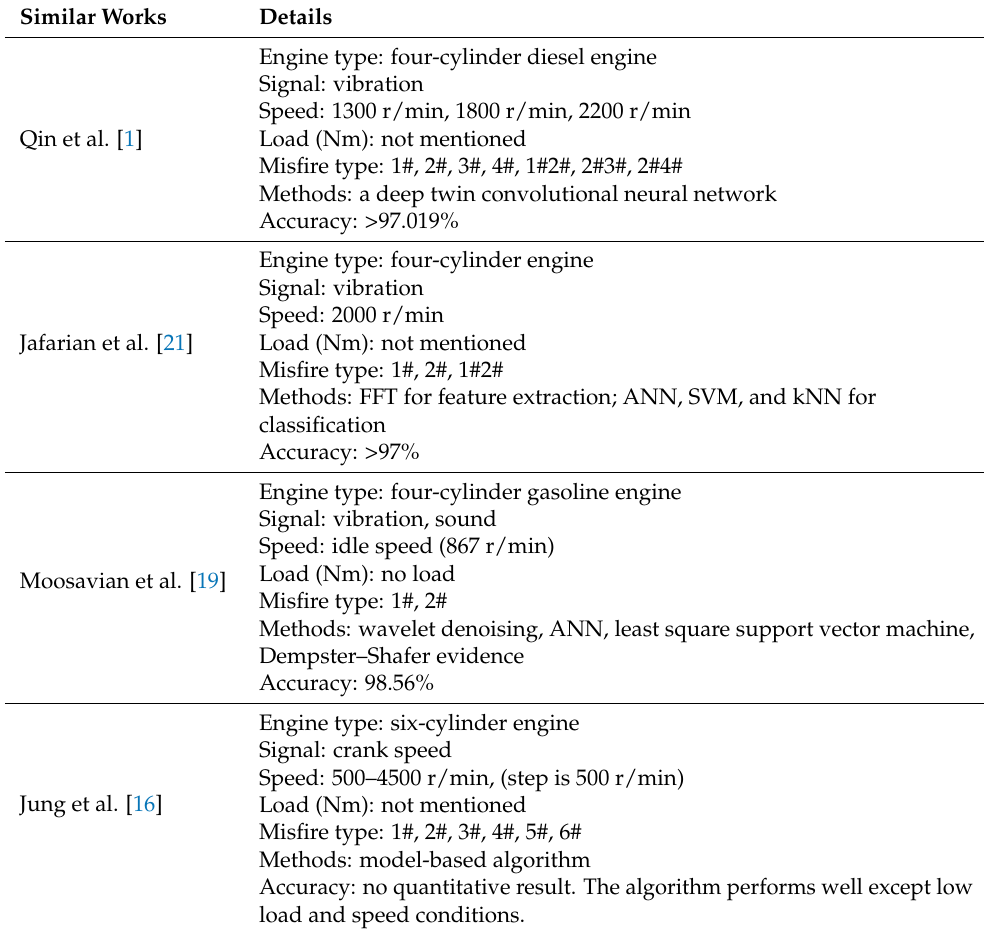
Table 6. Comparison of our results with the similar works in the literature. Similar Works